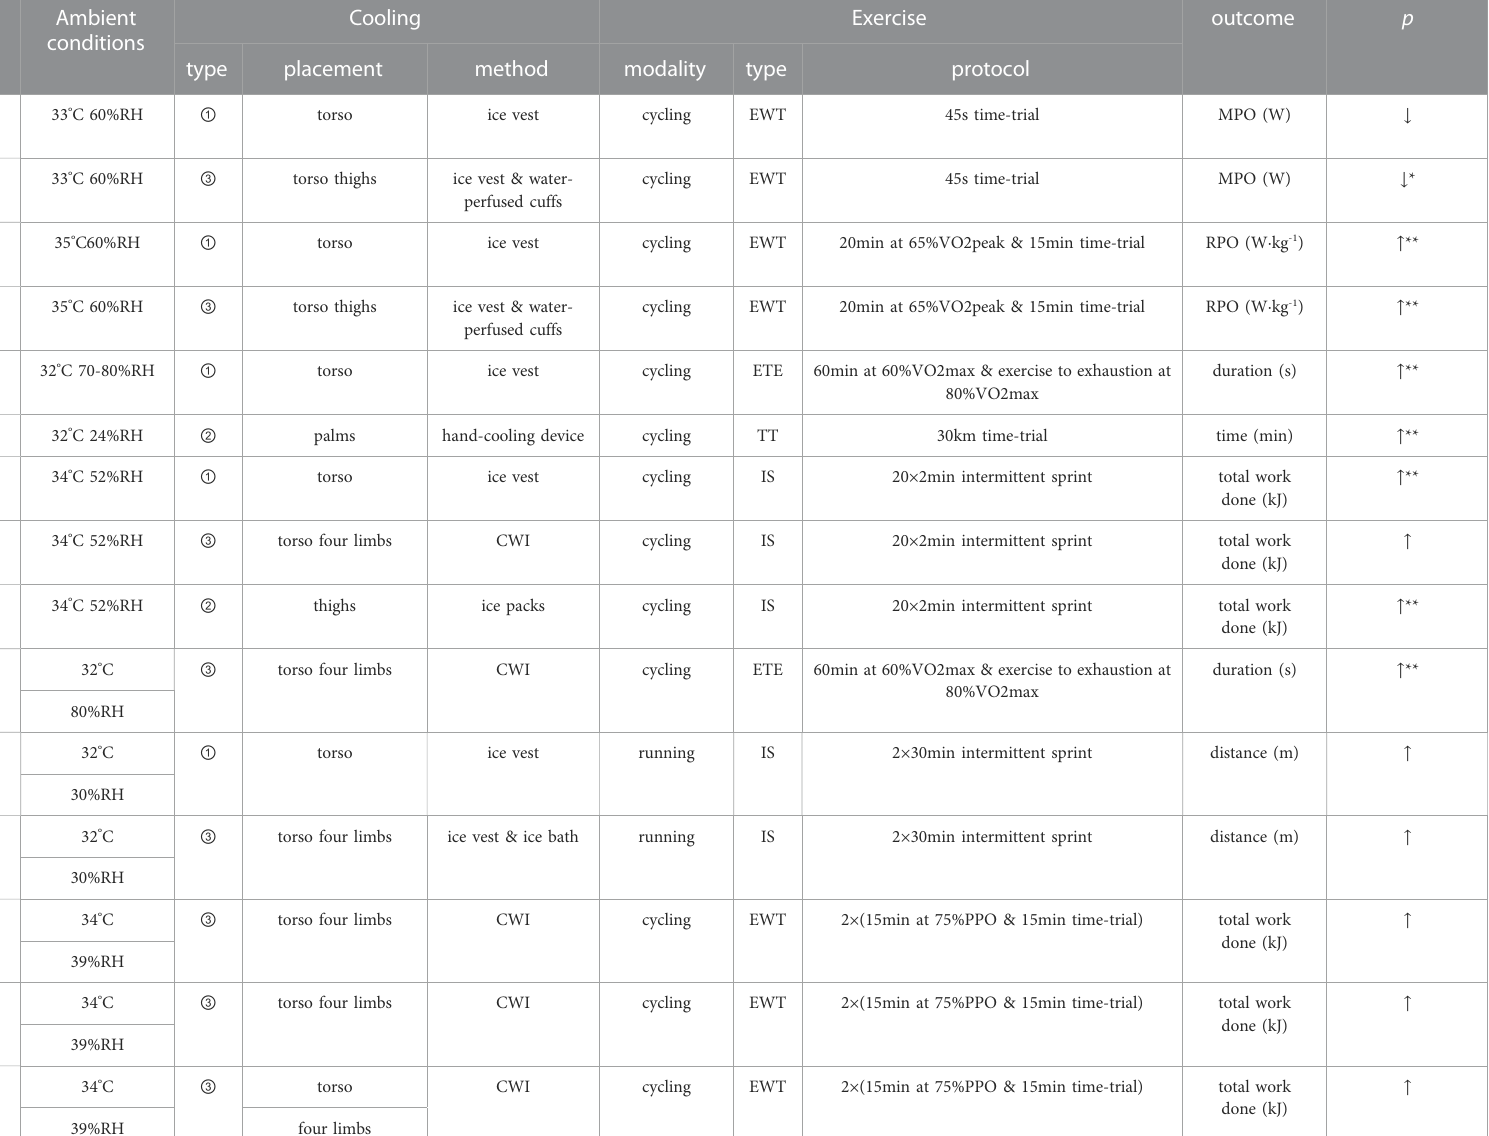
TABLE 1 Characteristics of the included